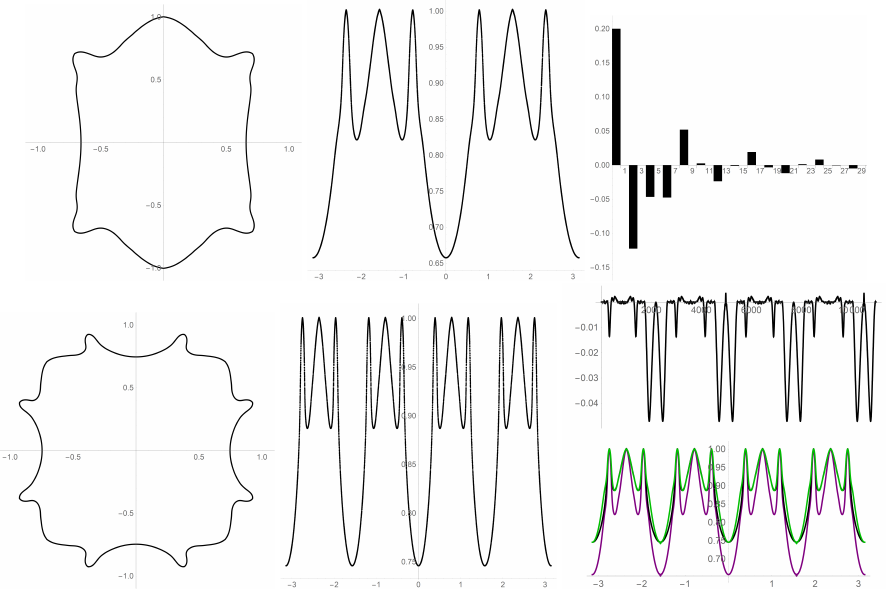
Figure 22. Analysis related to scaling of L ( C ( 2 ) ; z ) to L ( C ( k ) ; z ) (in this case k = 4). The top row of panels pertain to the main unity contour for L ( C ( 2 ) ; z ) . The top left shows the main unity contour. This translated to a ρ ( φ ) versus φ plot in the middle panel. The top right panel shows the Fourier decomposition of the curve in the middle panel (the constant coefficient is 0.84 but has been cut off at 0.2 in order to show the other coefficients more clearly). The bottom left and middle panels are the analog of the top left and middle panels but for L ( C ( 4 ) ; z ) . The bottom right panel shows L ( C ( 4 ) ; ρ e i φ ) (black), L ( C ( 2 ) ; ρ e i 2 φ ) (purple), and quadratically scaled L ( C ( 2 ) ; ρ e i 2 φ ) (green), ( a 1 = 0.50607 and a 2 = − 0.33248). Finally, the residual is shown as